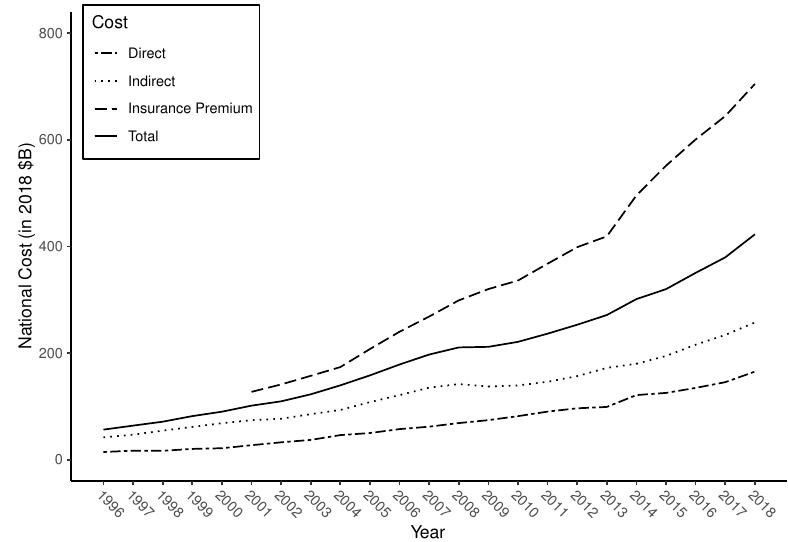
Figure 4. Total obesity-related cost with the breakdown between direct and indirect cost for the time period 1996 to